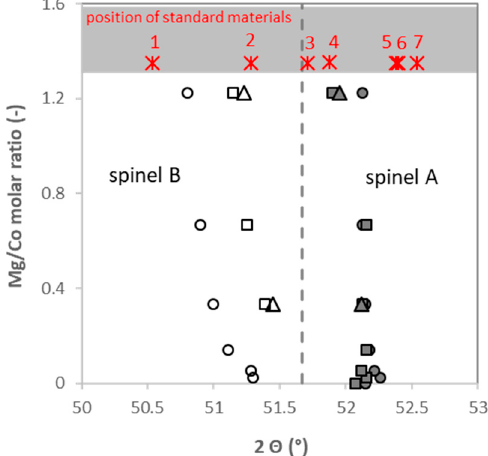
Figure 4. The 2 θ positions of (400) diffractions in spinel A and B in the a K/Mg i catalysts and standard spinel end-members. Legend: circle–0K/Mgi, square–2K/Mgi, triangle–4K/Mgi, 1—Al 0.54 Mg 0.51 Mn 1.95 O 4 (PDF No. 01-079-6007), 2—MnCo 2 O 4 (PDF No. 00-023-1237), 3—MnAl 2 O 4